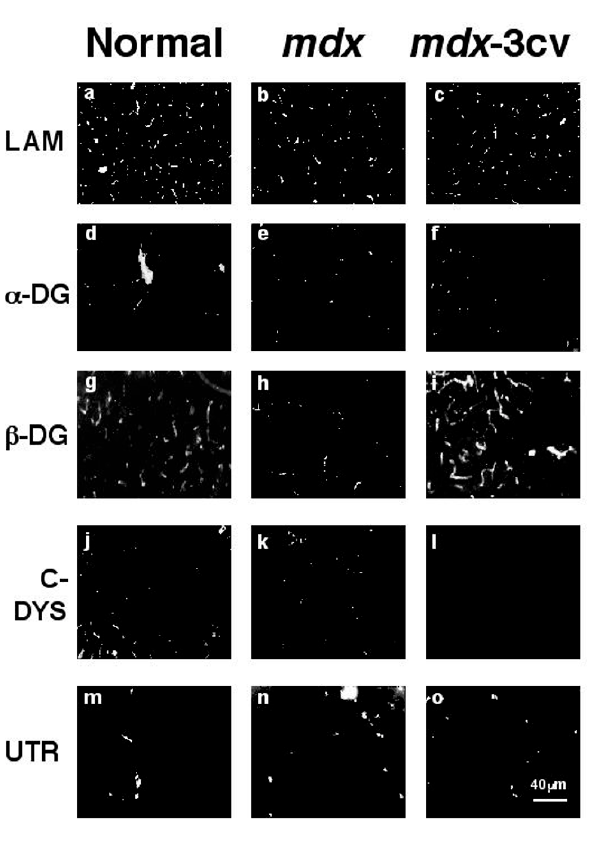
Figure 4 Immunofluorescence localization of β -dystroglycan and associated components in forebrain from dys- trophic animal models. Shown are cryosections labeled with antibodies to laminin (LAM) (a-c), α -dystroglycan ( α - DG) (d-f), β -dystroglycan ( β -DG) (g-i), the carboxy-terminus of dystrophin (C-DYS) (j-l), and utrophin (UTR) (m-o). Fore- brain specimens were taken from normal mice (a, d, g, j, m), mdx mice (b, e, h, k, n) and mdx -3cv mice (c, f, i, l, o). Bar = 40 µ m. can subcomplex were not studied. The immunoblot of Fig. 7d confirms the status of the mdx -3cv brain and demonstrates the absence of the Dp71 isoform in this an- imal model. In analogy to previous studies on dystrophic skeletal muscle [3], certain utrophin isoform levels were found to be elevated in Dp427-deficient and Dp71-defi- cient brain specimens. Both Up116 and Up71 were great- ly increased in mdx -3cv brain microsomes (Fig. 7f,g), while full-length utrophin did not seem to be affected in dystrophic brain (Fig. 7e).